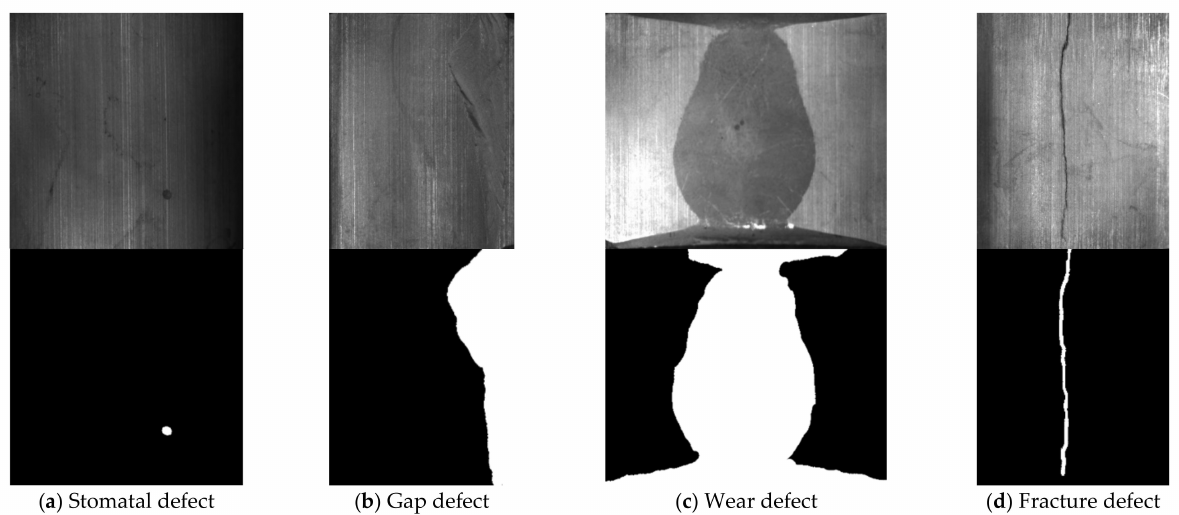
Figure 7. The samples with large scale difference of surface defects of magnetic tile and their corresponding defect labeling positions.